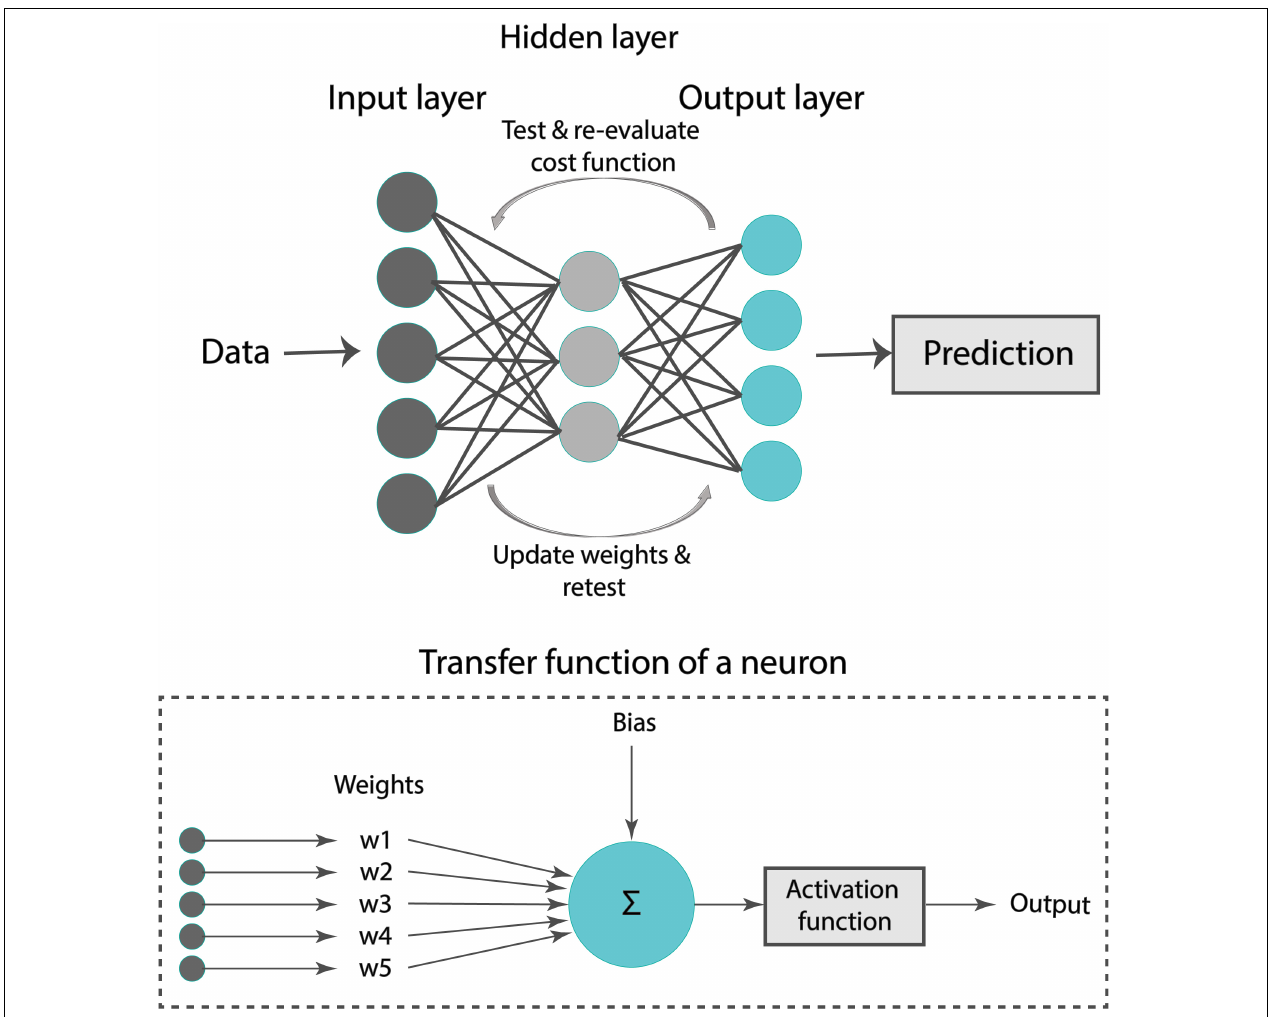
FIGURE 4 | Typical representation of an artificial neural network.